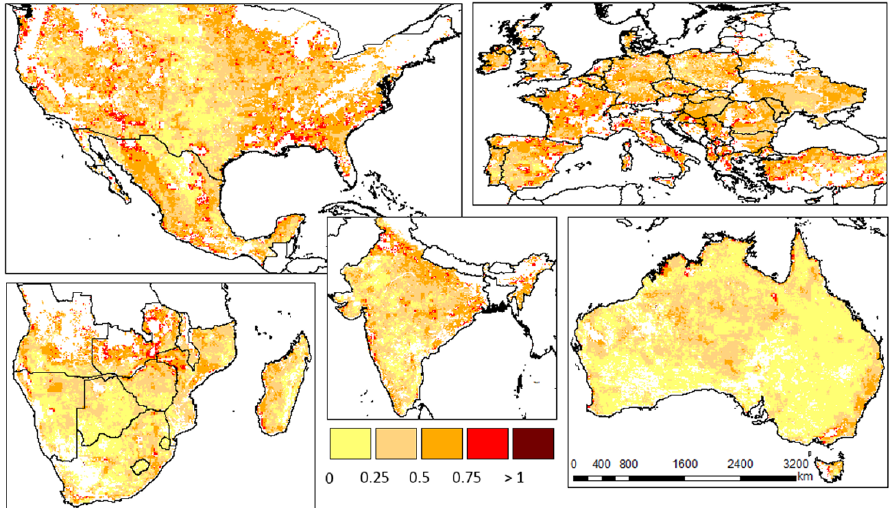
Figure 7. Spatial distribution of the error variance for the ESA Climate Change Initiative (CCI) dataset over the five selected